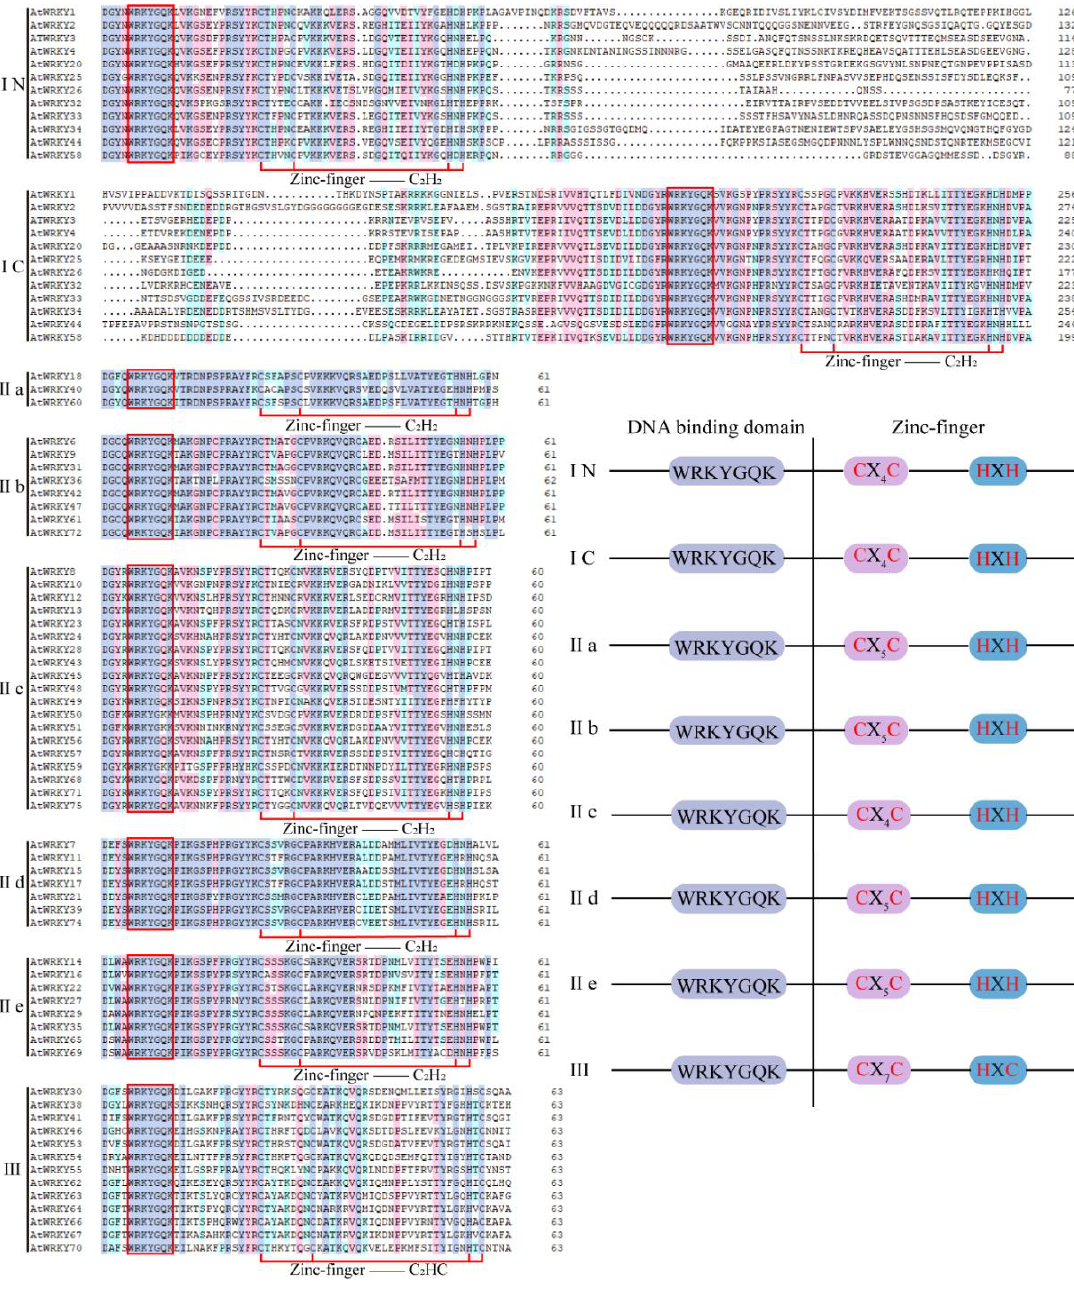
Figure 1. The domain of WRKY genes in Arabidopsis thaliana . The WRKY gene family is classified into the I ( I N and I C ), I Ia , IIb , IIc , IId , IIe , and III subfamilies. The aligned conserved domains (DNA binding and zinc-finger structures) are highlighted (left panel) and simplified (right panel).